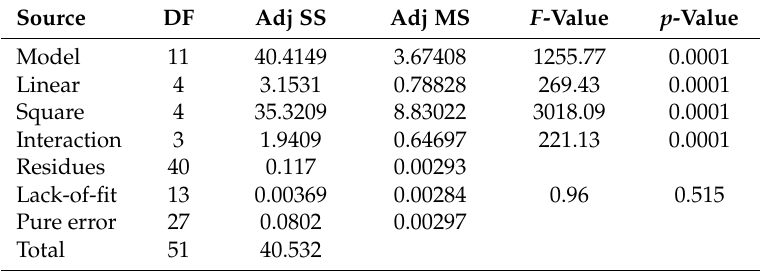
Table 9. An example of Analysis of Variance (ANOVA) for Response Surface Methodology fitted to a second-order polynomial equation. The table depicts R-squared ( R 2 ), Adjusted R-squared (Adj- R 2 ), Predicted R-squared (Pred- R 2 ), degree of freedom (DF), adjusted sum of square (Adj SS), adjusted mean square (Adj MS), F -value and p -value of the model.